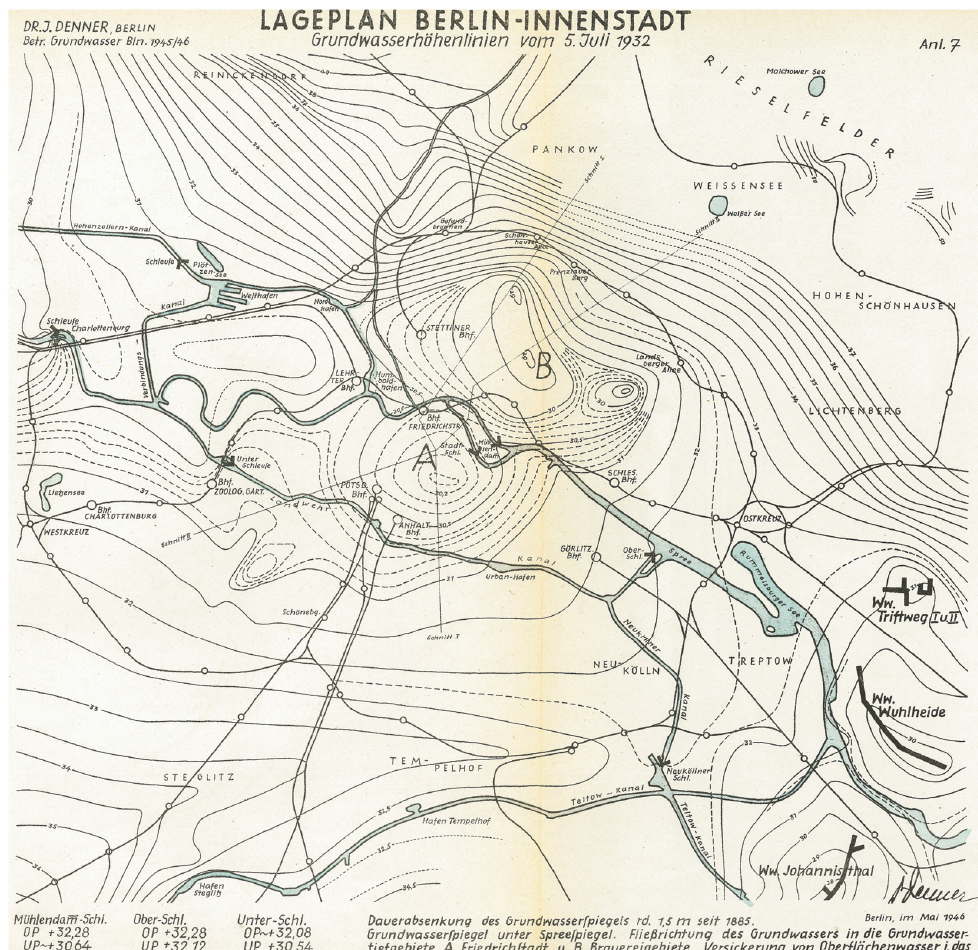
Figure 2. Map of groundwater levels in the centre of Berlin, 1932 ( adapted from Ref. [75]) (annex 7).